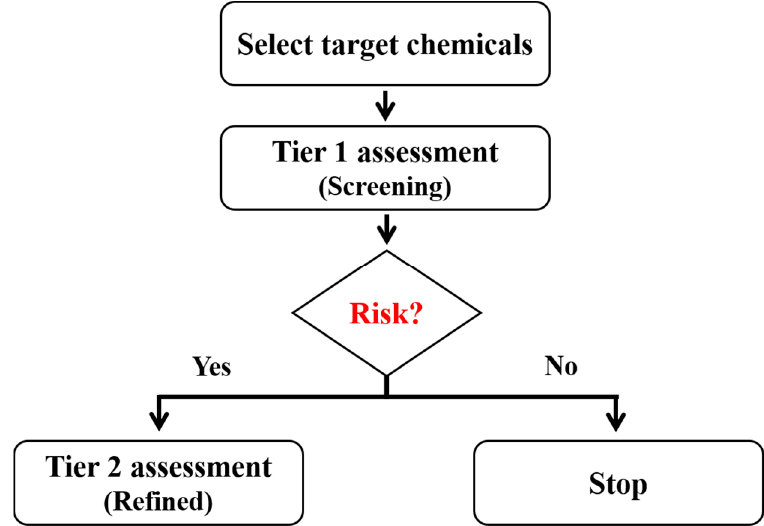
Figure 1. Workflow for tier 1 and 2 assessments.